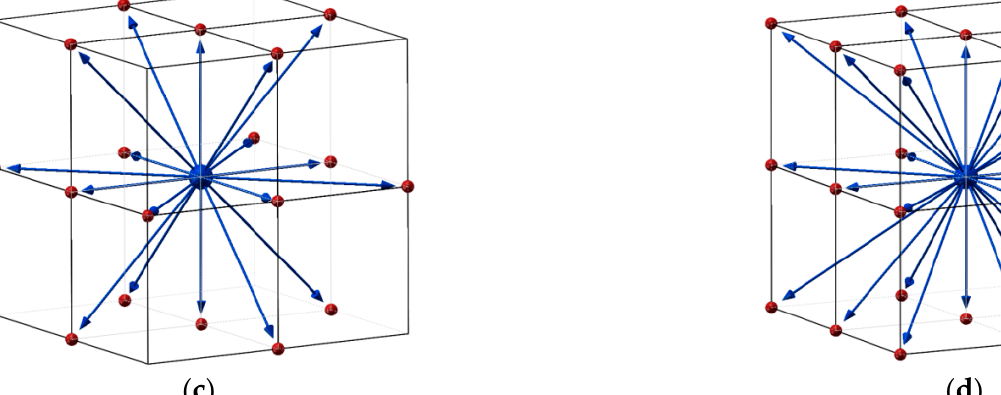
In this study, the speed model D3Q19 was selected, and its model is shown in Figure 2.